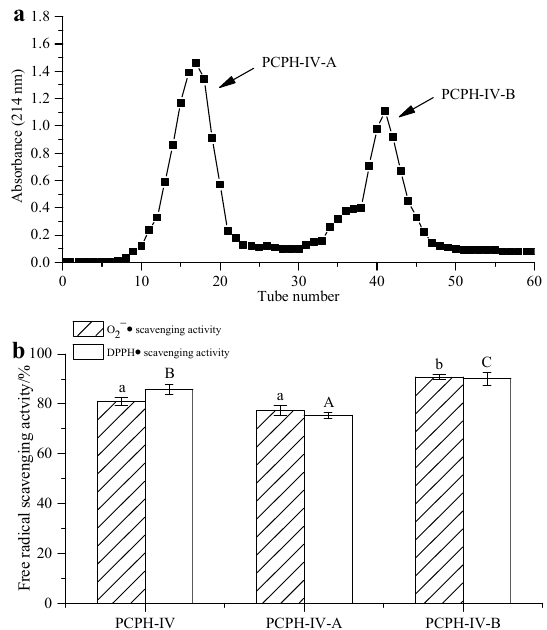
Figure 4. Separation of PCPH-IV by ion exchange chromatography: ( a ) chromatogram of PCPH-IV from cation exchange chromatography; ( b ) free radical scavenging activity of PCPH-IV fractions obtained from cation exchange chromatography. Identical same-case letters above the bars indicate no significant difference ( c = 20 mg/mL, p > 0.05).